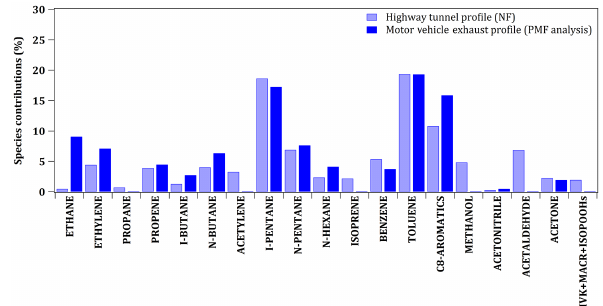
Figure 9. Comparison of speciated profiles issued from the high- way tunnel experiment and PMF simulations (F1 – motor vehi- cle exhaust). The species contributions are expressed in percent. NF =